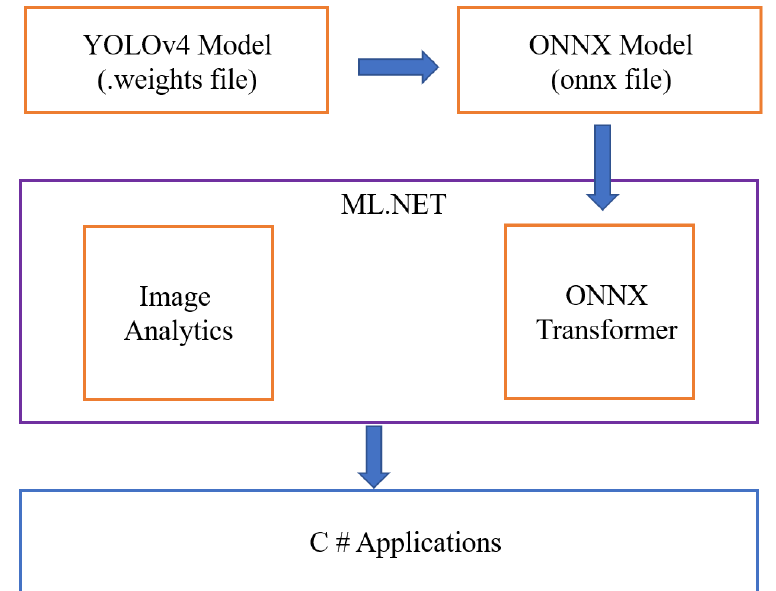
Figure 14. NET integrated deep learning model